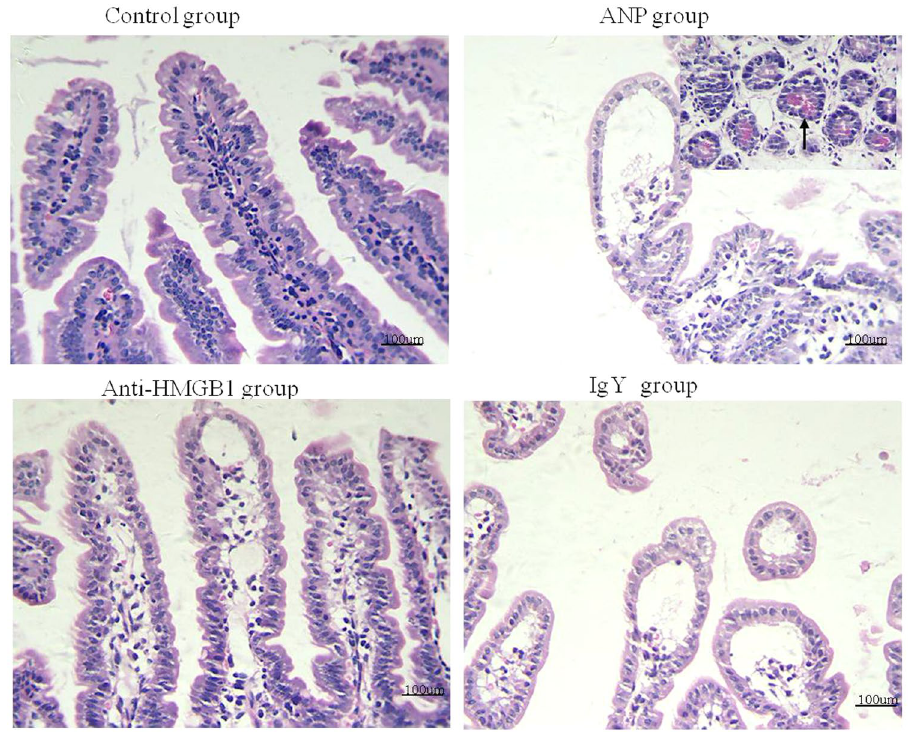
Figure 4. Representative H&E-stained sections of ileum. The original magnification is x400. Ileal mucosal injury was presented in ANP group characterized by irregularity and shedding of lamina propria with short, scanty, and denuded villi, increased paneth cells with more granules. Anti-HMGB1 antibody treatment attenuated AP-induced mucosal injury. (Black arrow: paneth cell with increased granules).